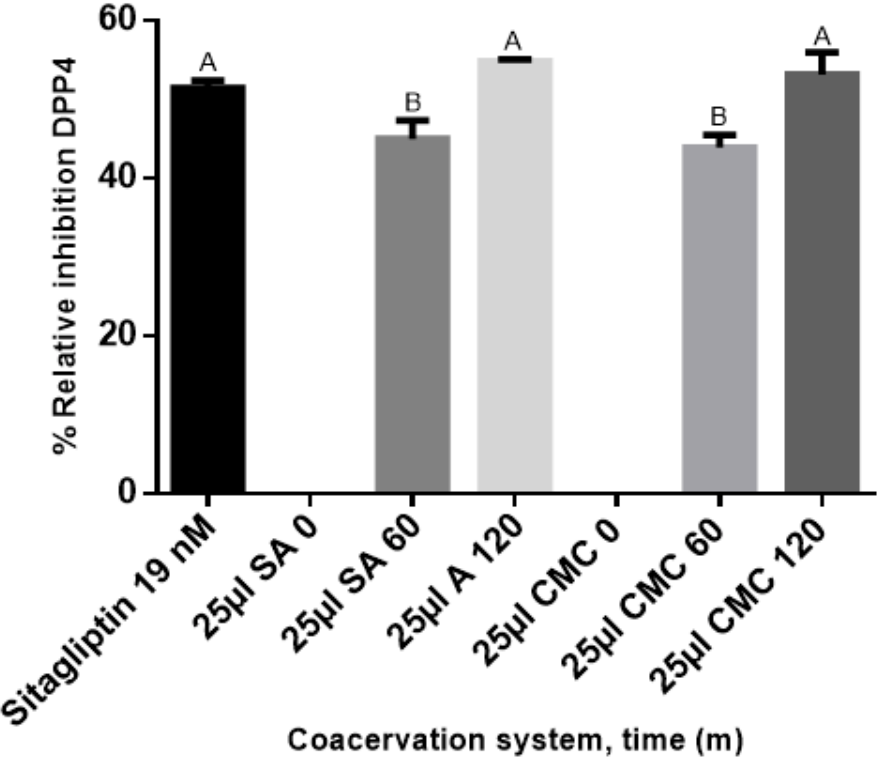
Figure 8. DPP-4 inhibition activity of hydrolysates resulting from intestinal in vitro digestion of empty microcapsules coacervated with sodium alginate (SA) or carboxymethyl cellulose (CMC) at different hydrolysis times (0, 60, and 120 min). Sitagliptin was used as the reference standard.